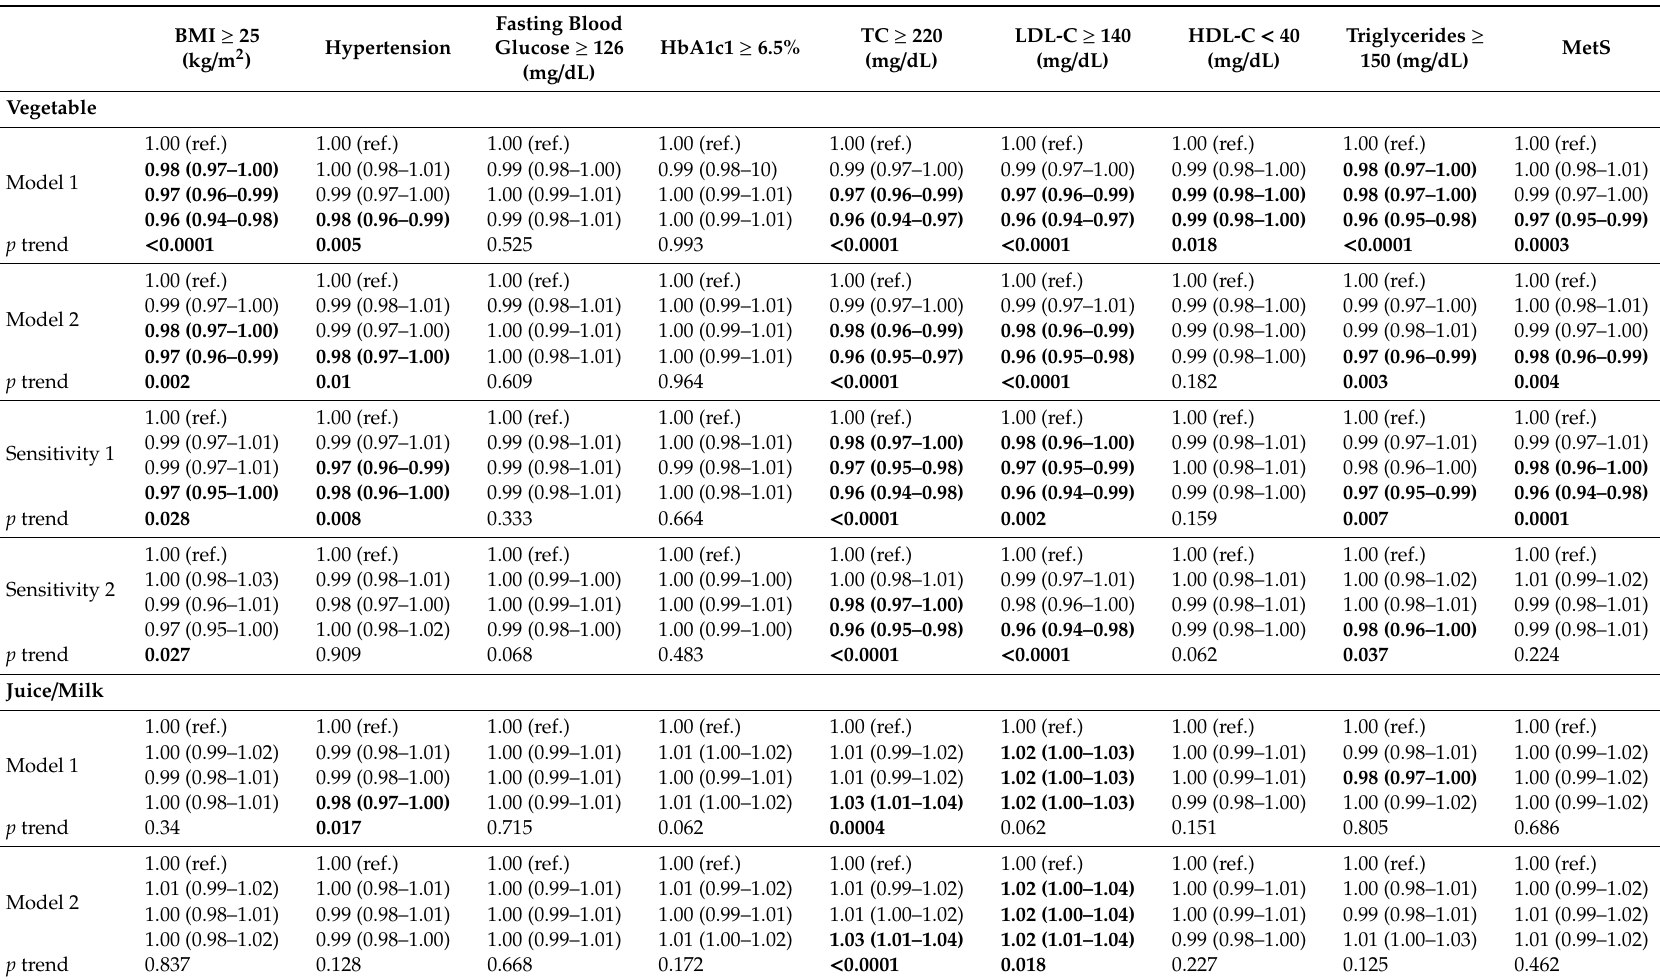
Table 4. Prevalence ratios (PRs, 95% CIs) for cardiometabolic factors in 2014 by quartiles of accumulative means of dietary pattern scores during 2011–2013,